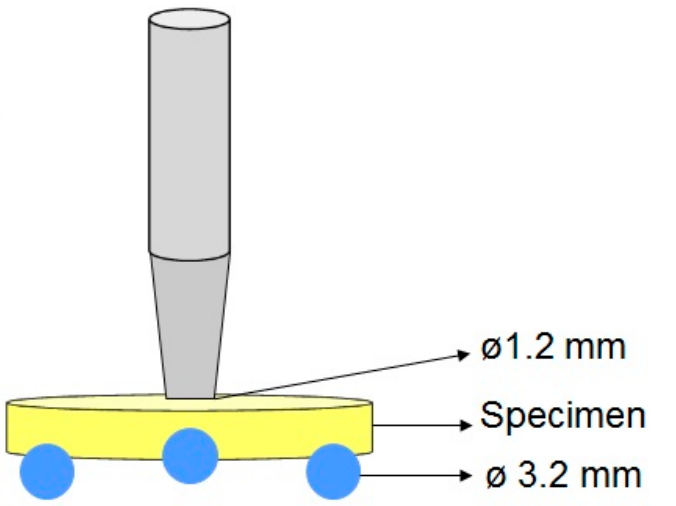
Figure 3. Schematic presentation of three-ball piston setup for BFS test.